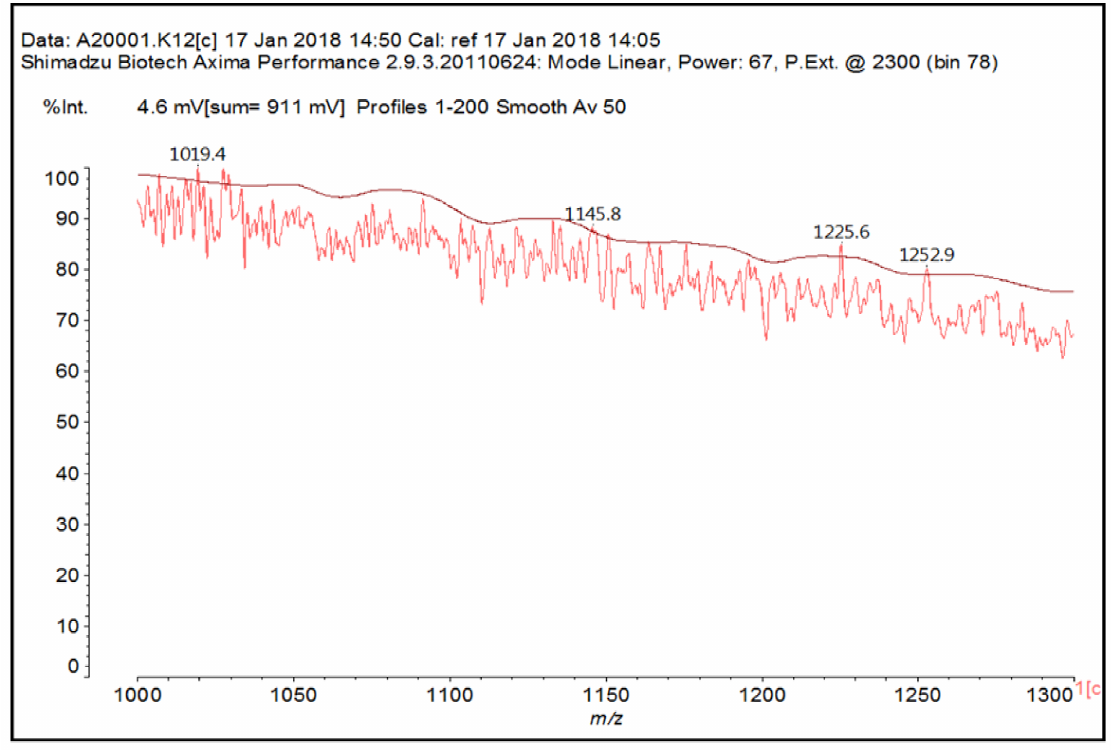
Figure 12. MALDI ToF spectrum of the A2 NIPU resin. Detail of the 1000–1300 Da range. Of further interest are the results of CP MAS 13 C NMR analysis of A1 carbonated glucose and of the A2 glucose-based non-isocyanate polyurethane resin shown in Figures 13 and 14. These indicate that species other than those identified by MALDI ToF also occur in the reaction mixture.